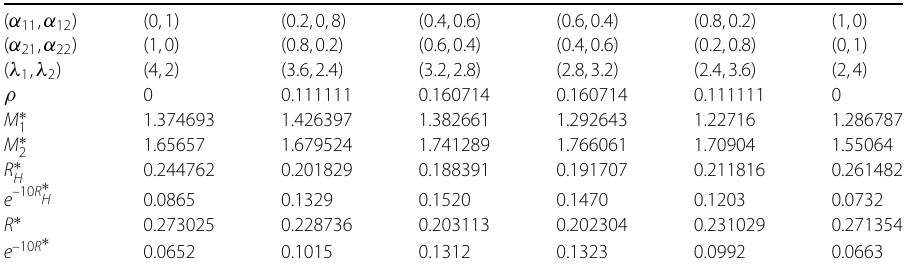
Table 2 Comparison of Lundberg exponent: exponential case. ( θ 1 , θ R ) = (0.25,0.5), values of Lundberg exponent and upper bound of ruin probability with different ( θ 2 , θ R 2 dependence parameters for Hu’s model and our